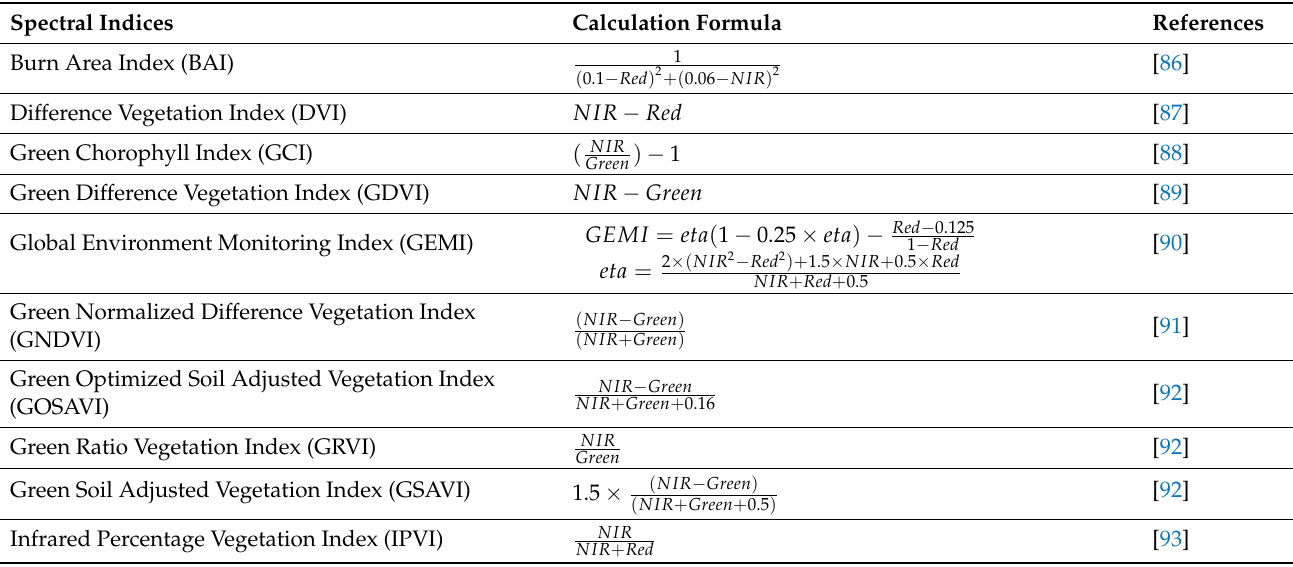
Table 3. The broad-band spectral indices used in this